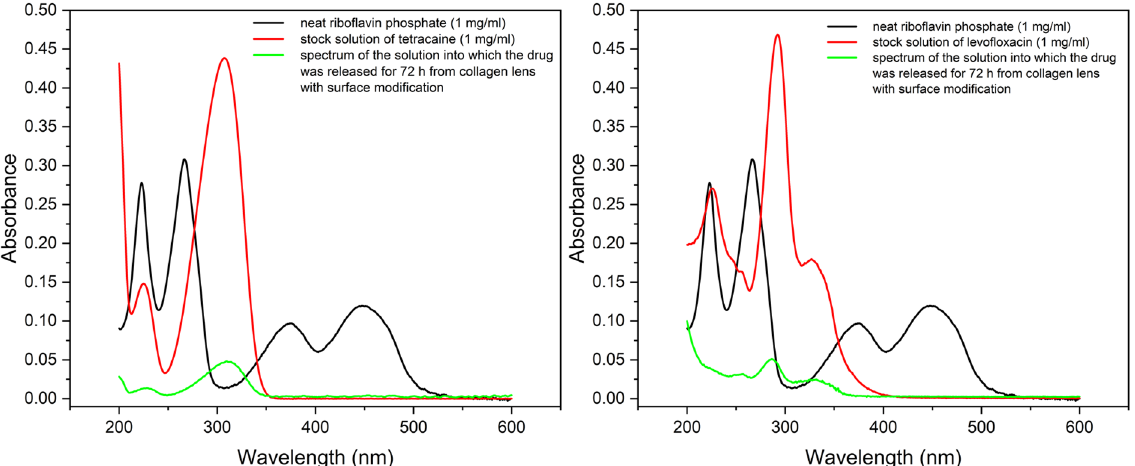
Figure 9. Comparison of UV-Vis spectra of neat riboflavin phosphate (black), neat Tetracaine ( right , red), neat ( left , red) and solutions after drug release from the crosslinked collagen carriers (green).